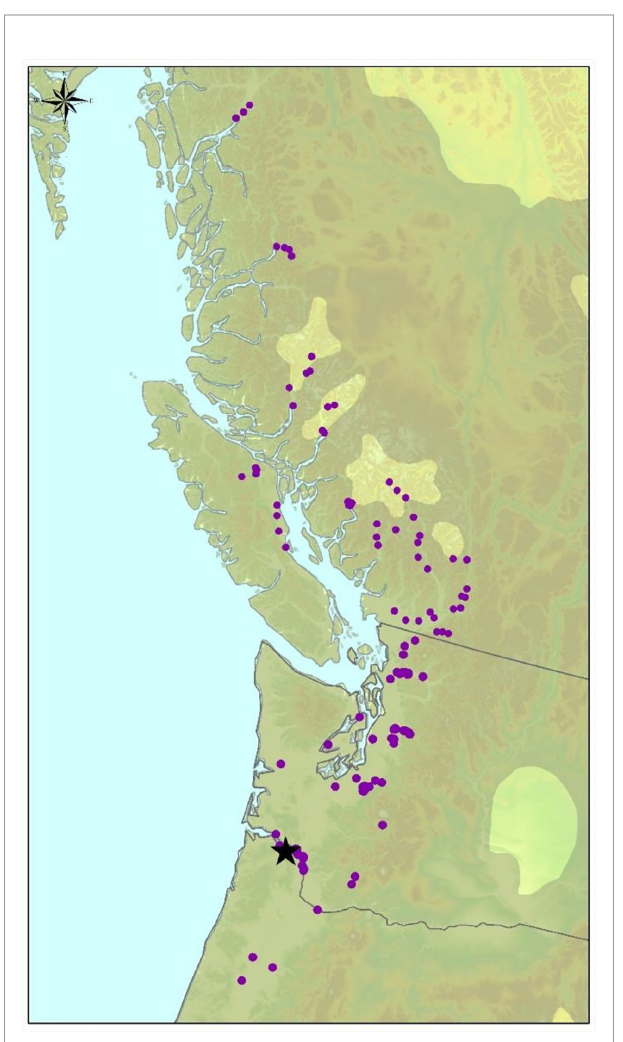
FIGURE 1 | Source locations of 869 P . trichocarpa genotypes sampled in this study (purple dots). The trees were grown in a common garden in Clatskanie, Oregon, USA (black